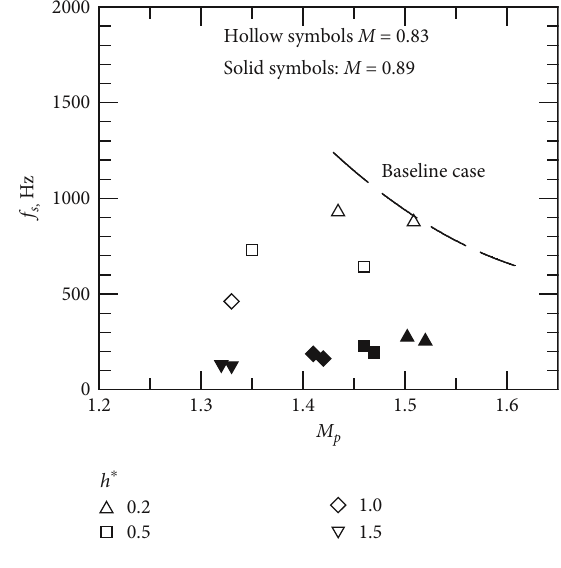
Figure 11: Shock zero-crossing frequency.